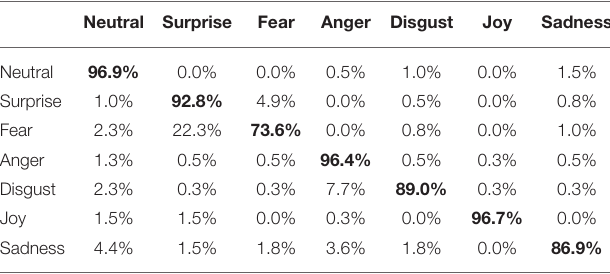
TABLE 1 | Emotion recognition rate for each emotion depicted. The average rate is 90.3 %